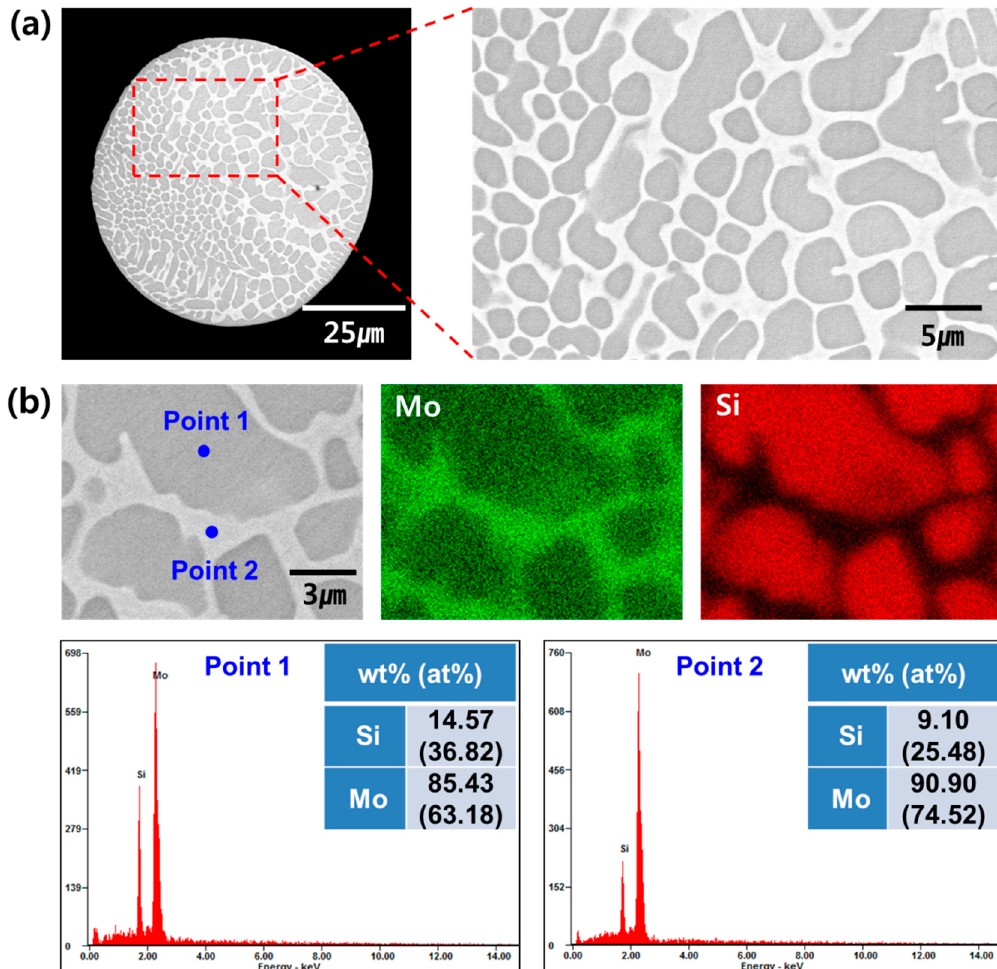
Figure 5. ( a ) Cross-sectional microstructure of the powder observed by back-scattered electron imaging, and ( b ) EDS area and point analyses result. Points 1 and 2 were determined as Mo 5 Si 3 and Mo 3 Si,